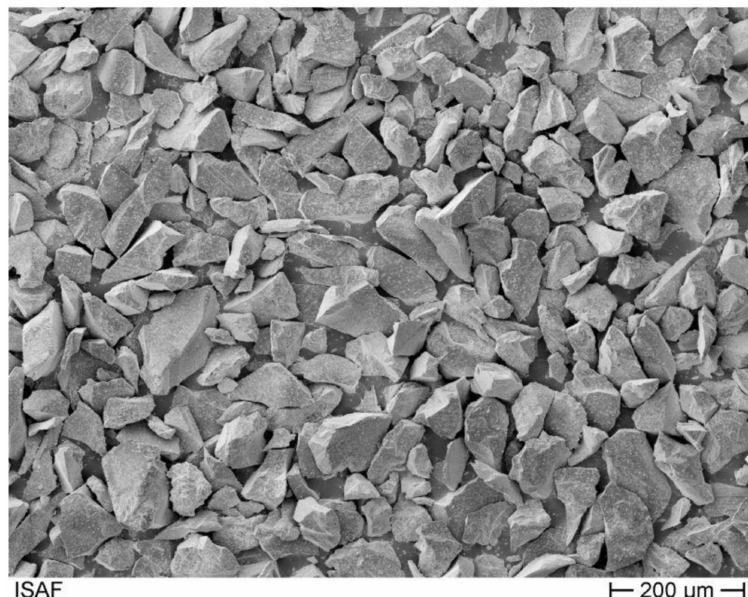
Figure 2. SEM Image of corundum F220